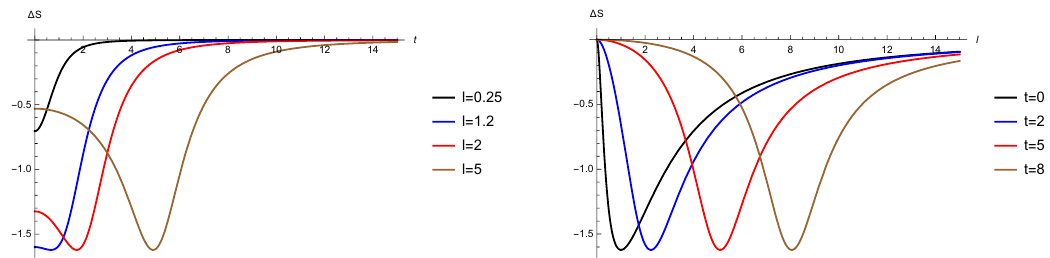
Figure 9 : Left: time dependence of ∆ S for a spherical subregion with fixed radius l centered at the origin of the quench. Right: dependence of ∆ S at fixed t as a function of = 1 , A = 1 are l . The numerical values α H